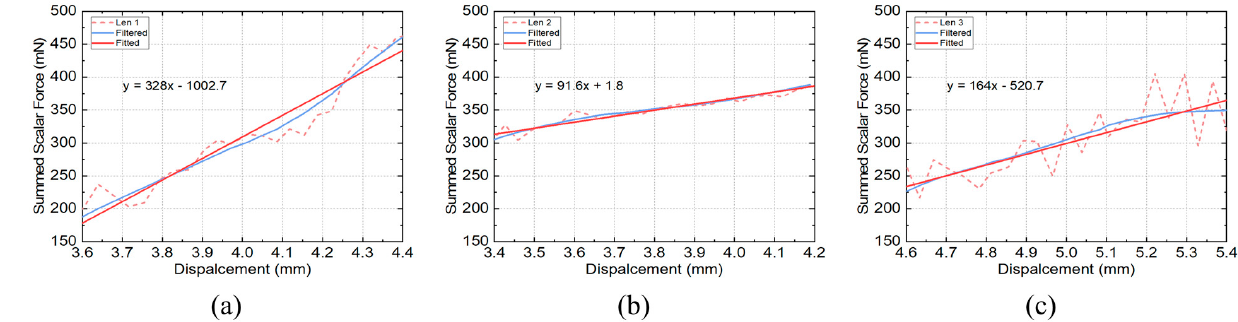
Figure 8. Measured force–displacement data and their corresponding filtered and fitted results of three different porcine eye samples. ( a ) porcine eye sample one, ( b ) porcine eye sample two and ( c ) porcine eye sample three.